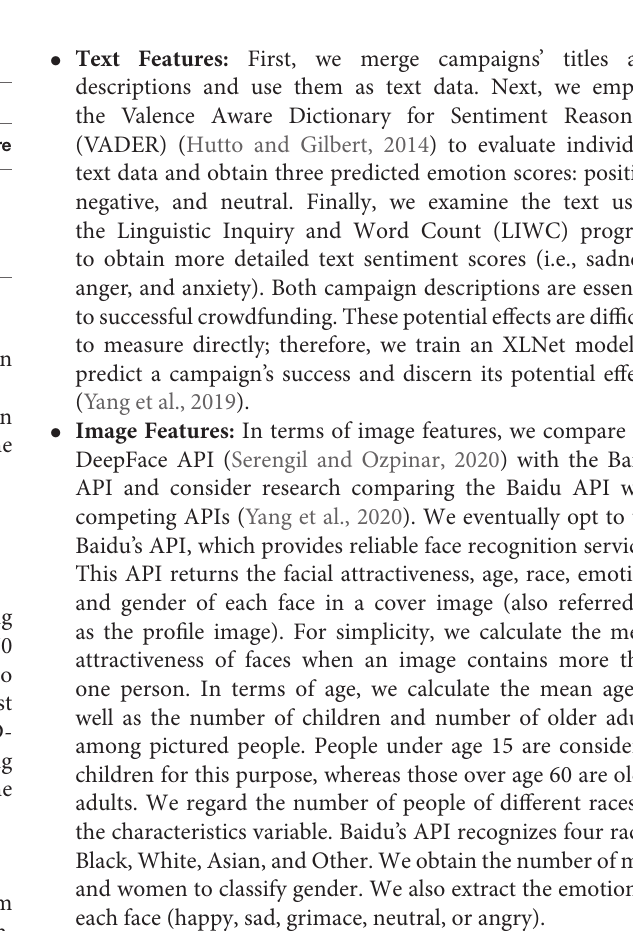
FIGURE 1 | Category distribution (best viewed by zoom-in on screen).